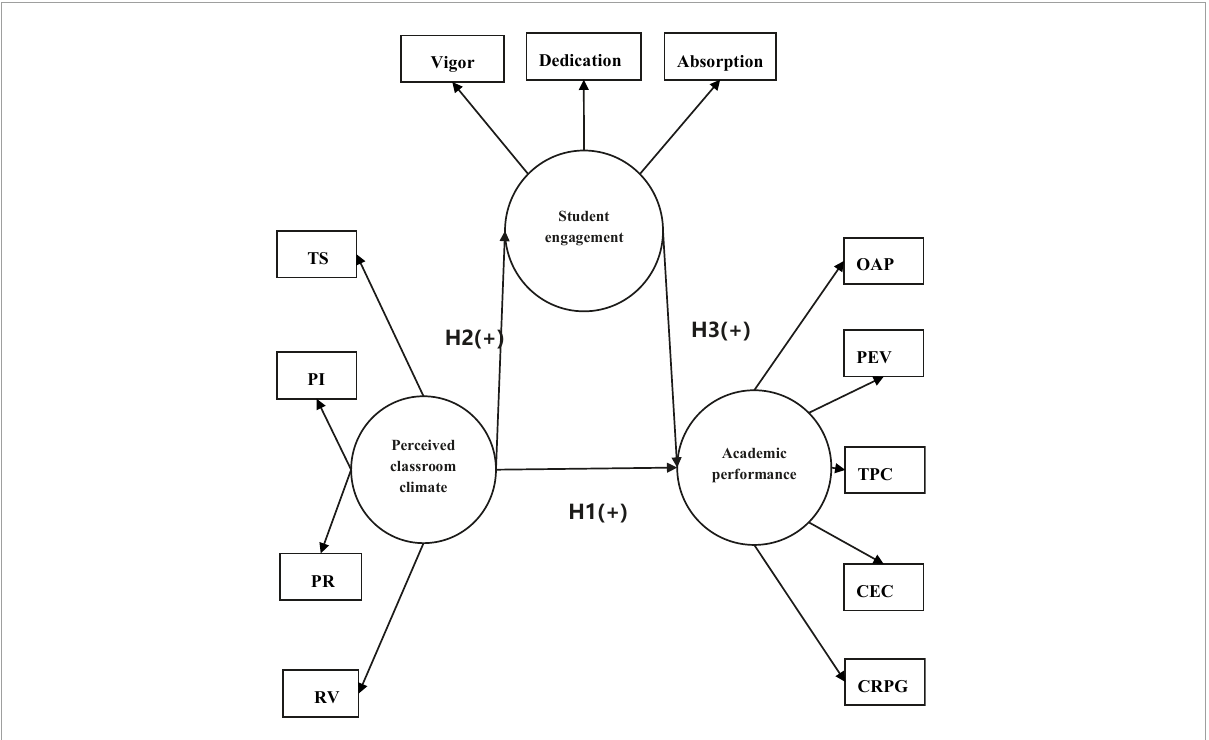
FIGURE1 Research hypotheses. TS-academic support from teachers, PI-promoting interaction, PR-promoting mutual respect, RV-respect for viewpoints, OAP-overall academic performance, PEV-professional ethics values, TPC-teaching practice competence, CEC-comprehensive education competence, CRPG-competence in reflection and professional